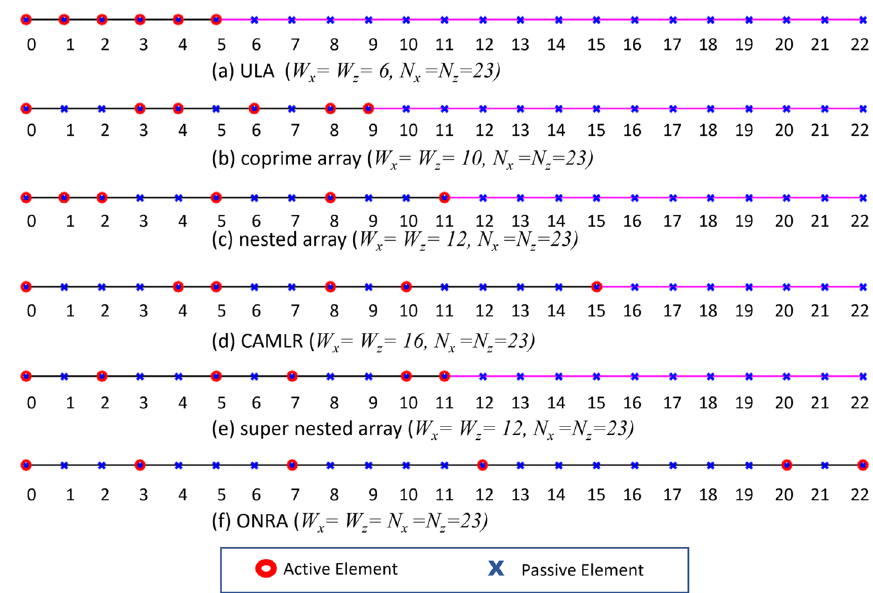
Fig. 2 Single-axis array structures of different types sparse arrays under